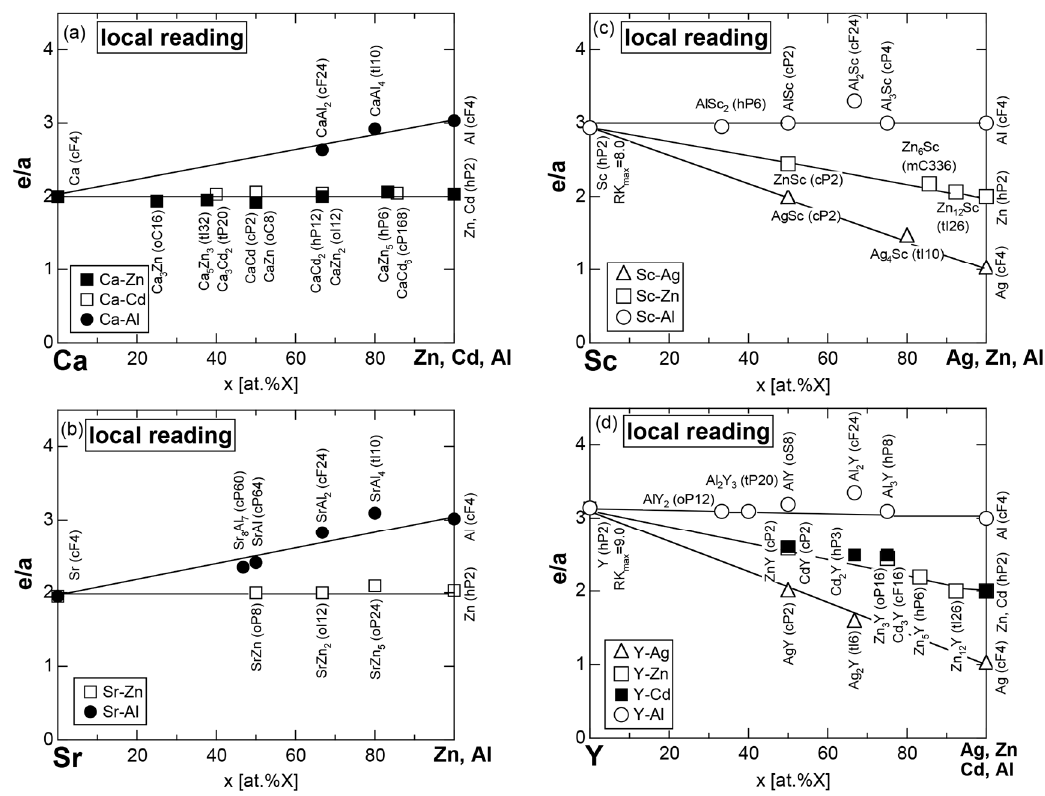
Figure 95. Composition dependence of e/a for intermetallic compounds and pure elements in ( a ) Ca–M (M = Zn, Cd, Al), ( b ) Sr–M (M=Zn, Al), ( c ) Sc-M (M = Ag, Zn, Al) and Y-M (M = Ag, Zn, Cd, Al) alloy systems [37]. The local reading method is exclusively employed. The linear interpolation lines are drawn by connecting end points of pure elements in the respective alloy systems. Symbols in bracket refer to the Pearson symbol for elements and compounds.